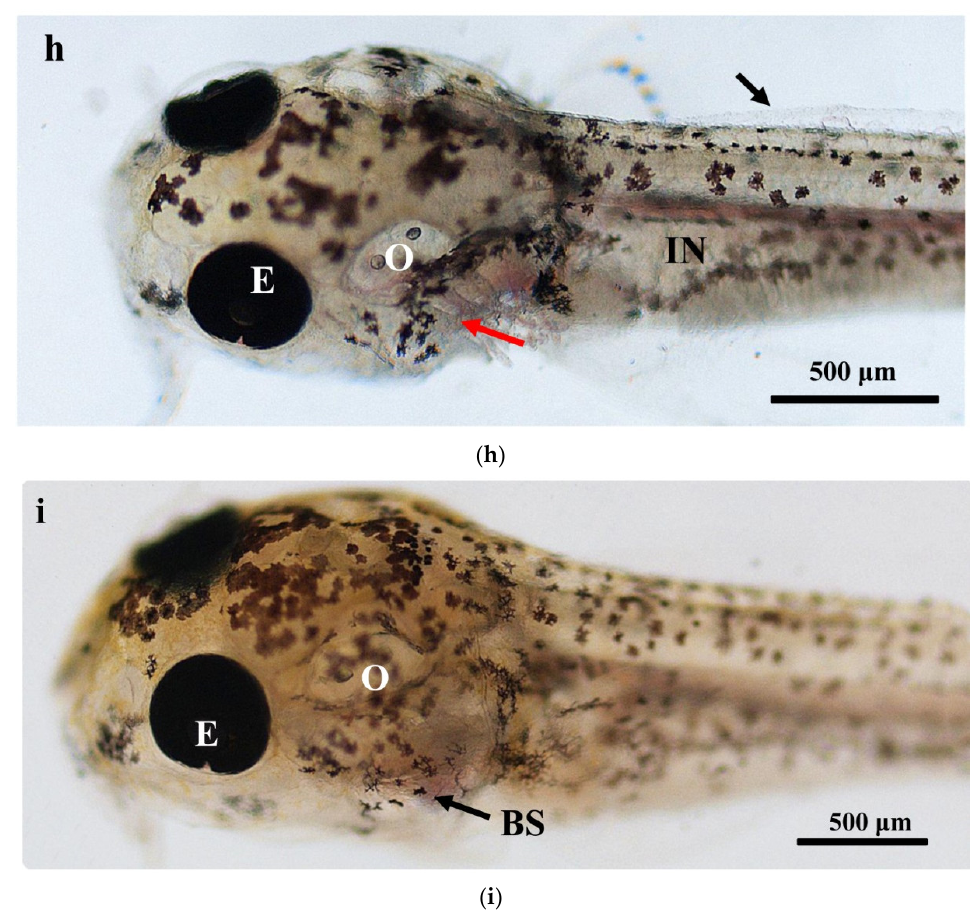
Figure 2. Morphological observation of ontogenetic development of external gill in P. dabryanus : ( a ) newly hatched larva; ( b ) 0.5 DAH larva; ( c ) 1 DAH larva; ( d ) 2 DAH larva; ( e ) 3 DAH larva; ( f ) 4 DAH larva; ( g ) 5 DAH larva; ( h ) 6 DAH larva; ( i ) 9 DAH juvenile. Red arrows: external gill; E: eye; IN: intestine; GA: gill arch; GR: gill raker; O: otolith; SF: secondary filament; YS: yolk sac.